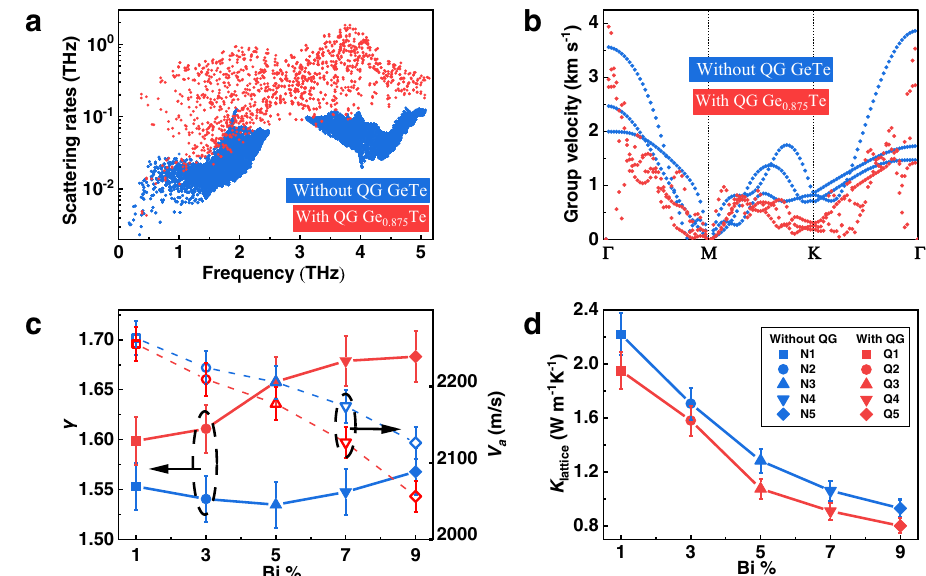
Fig. 4 | Theoretical analysis and experimental veri fi cation ofthe role of QGs in lattice thermal conductivity. a The calculated phonon scattering rates. b The calculated phonon group velocity. c The Grüneisen constant and average sound